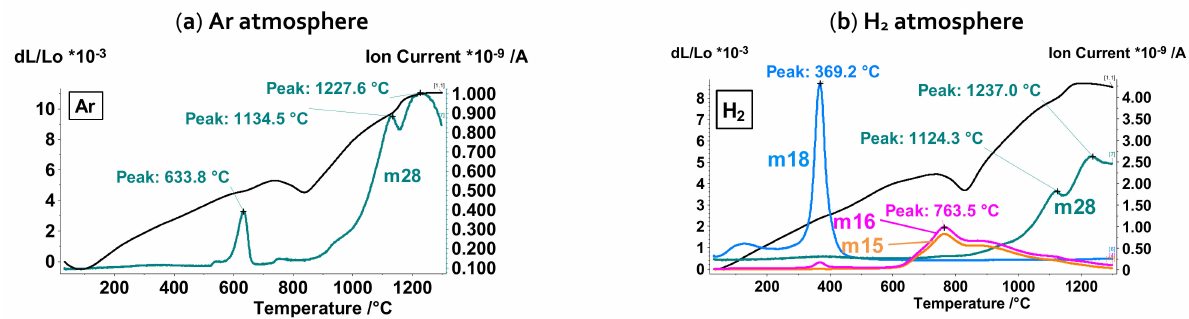
Figure 11. Dilatometry experiments coupled with mass spectrometry performed in green compacts that contain Fe-0.6%C- 4%AM, studies in different atmospheres: ( a ) Inert: Ar and ( b ) Reducing: H 2